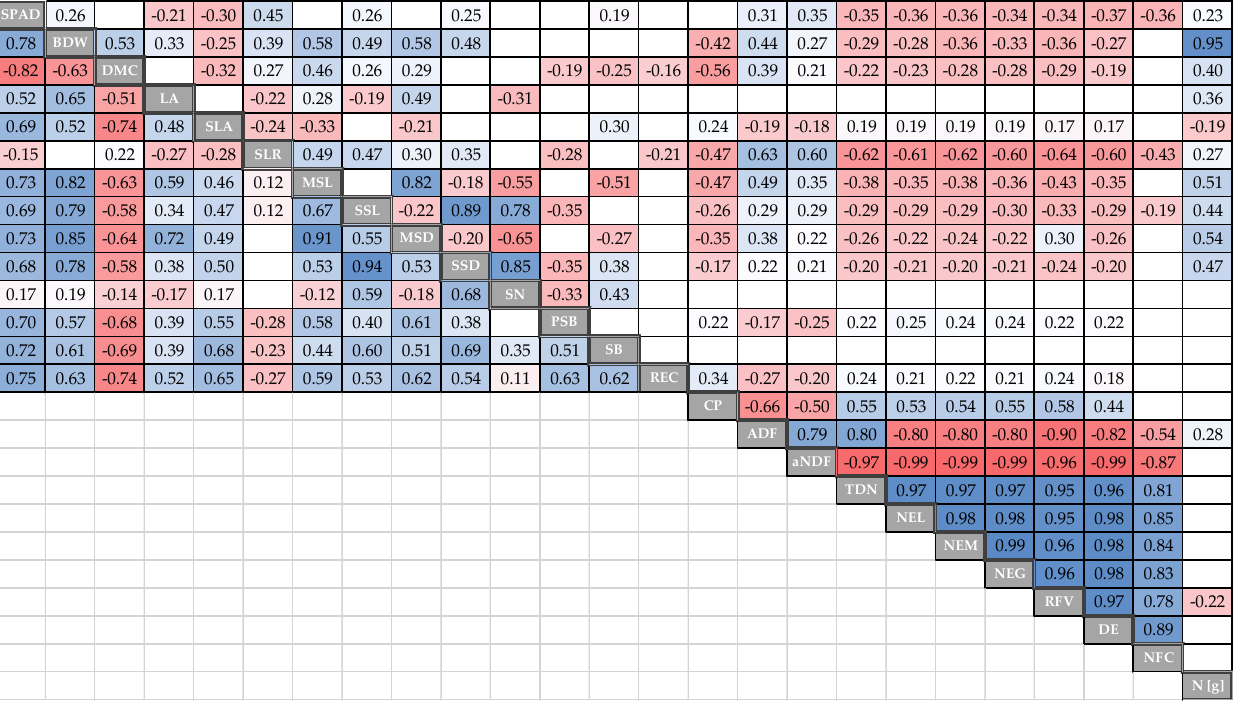
8 of 18 Figure 3. Mean values (±standard error) of SPAD readings over time for fertilized treatment (Fert) and water control. Table 3. Repeated measures quadratic polynomial analysis of variance results for SPAD measure- ment.